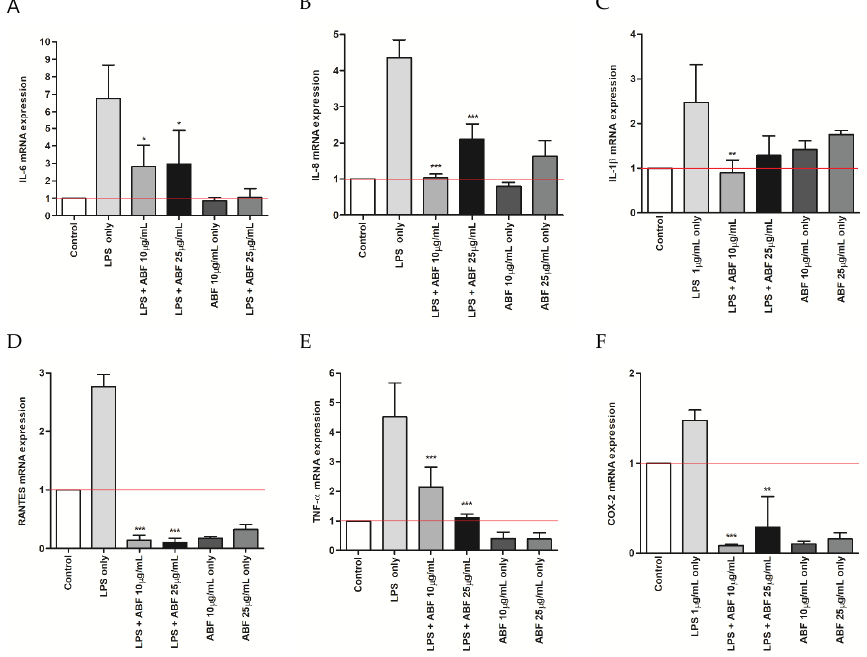
Figure 3. Effects of aronia bioactive fraction (ABF) on the lipopolysaccharide (LPS)-induced mRNA expression of interleukin (IL)-6 ( A ), IL-8 ( B ) and interleukin 1 beta (IL- 1β) ( C ) regulated upon activation, normal T cell expressed and presumably secreted (RANTES) ( D ), tumor necrosis factor (TNF)- α ( E ) and cyclooxygenase-2 (COX-2) ( F ). BEAS-2B cells were pretreated with ABF (10 and 25 μg/mL) 6 h before treatment with LPS (1 μg/mL). After incubation for 6 h, the mRNA was evaluated by quantitative real time-polymerase chain reaction. The values are presented as means ± standard deviation (SD) of three independent experiments. * p < 0.1, ** p < 0.05, *** p < 0.01 indicate significant differences as compared to the LPS-treated cells.